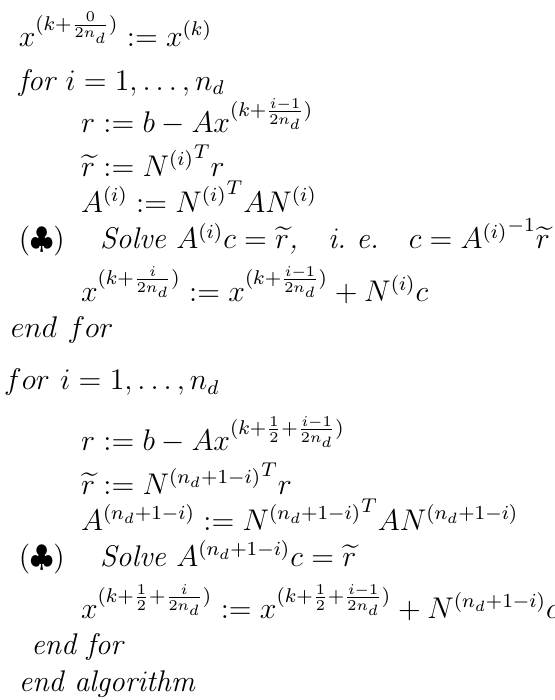
Algorithm 2.1. One step of the symmetrized Schwarz